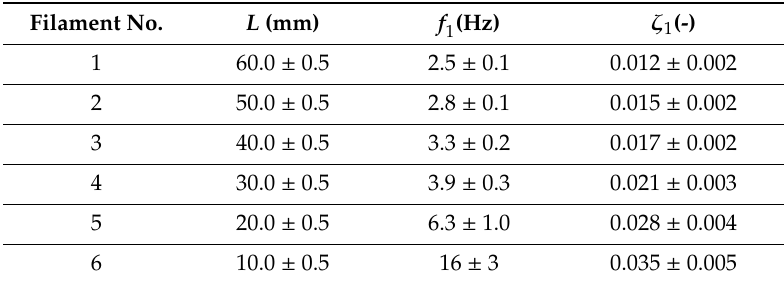
Table 2. Flexible filaments used in the present FSI